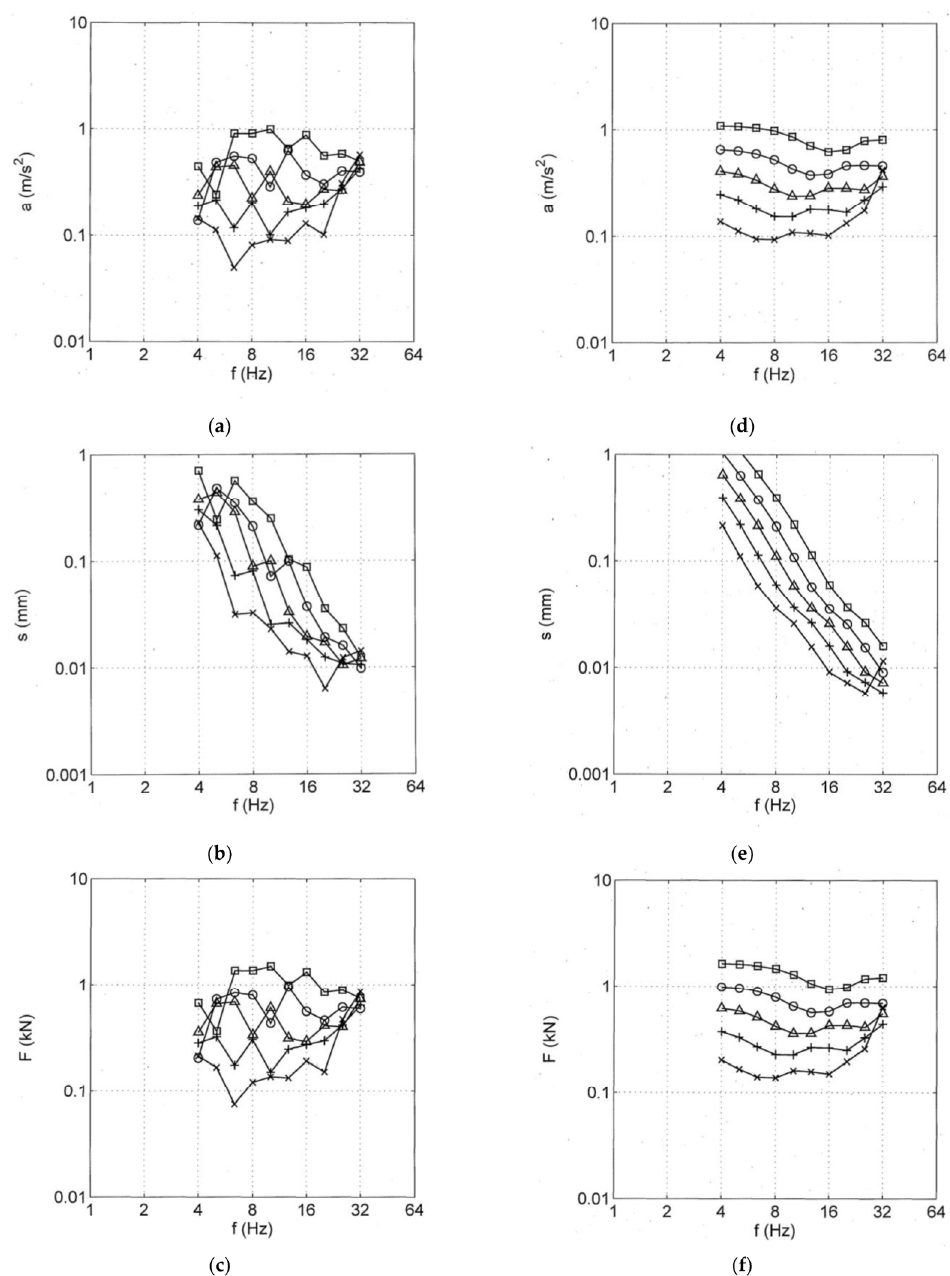
Figure 8. Measured ( a – c ) and calculated ( d – f ) vehicle–track interactions at site W for train speeds v T = □ 160, ○ 125, ∆ 100, + 80, and × 63 km/h; wheelset acceleration ( a , d ), effective irregularities ( b , e ), dynamic axle loads ( c , f ).